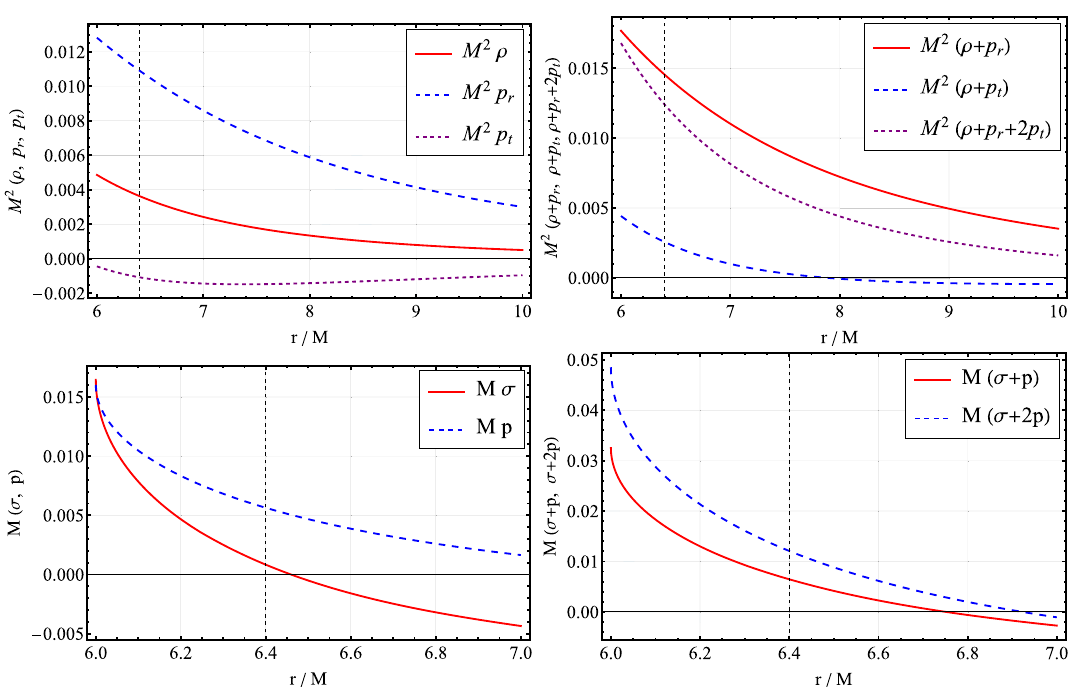
ζ = α = β = 1, r = 6 M and λ = − 9 π . Performing the matching 0 0 at r (cid:17) = 6 . 4 M , one verifies that the NEC, WEC and SEC are all satis- fied for both the interior and the exterior spacetimes, as well as at the separation hypersurface